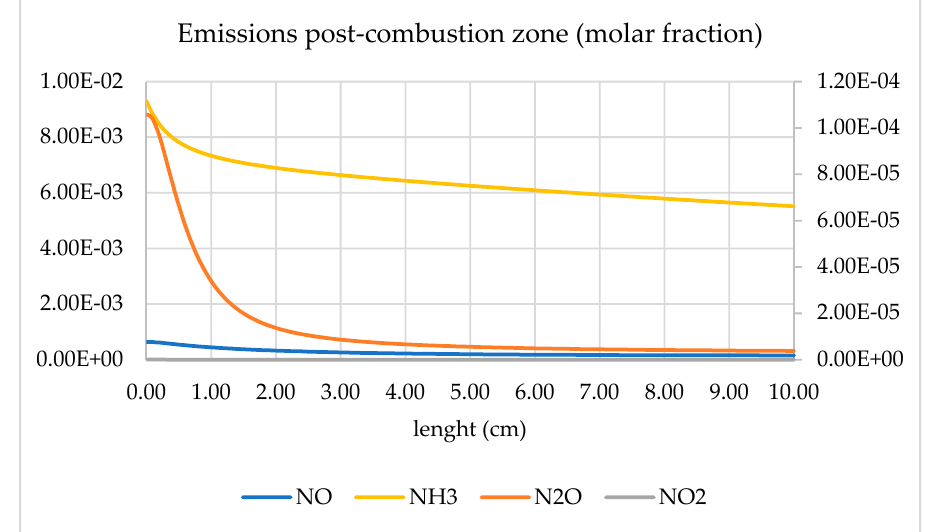
Figure 5. Emissions in post combustion zone.